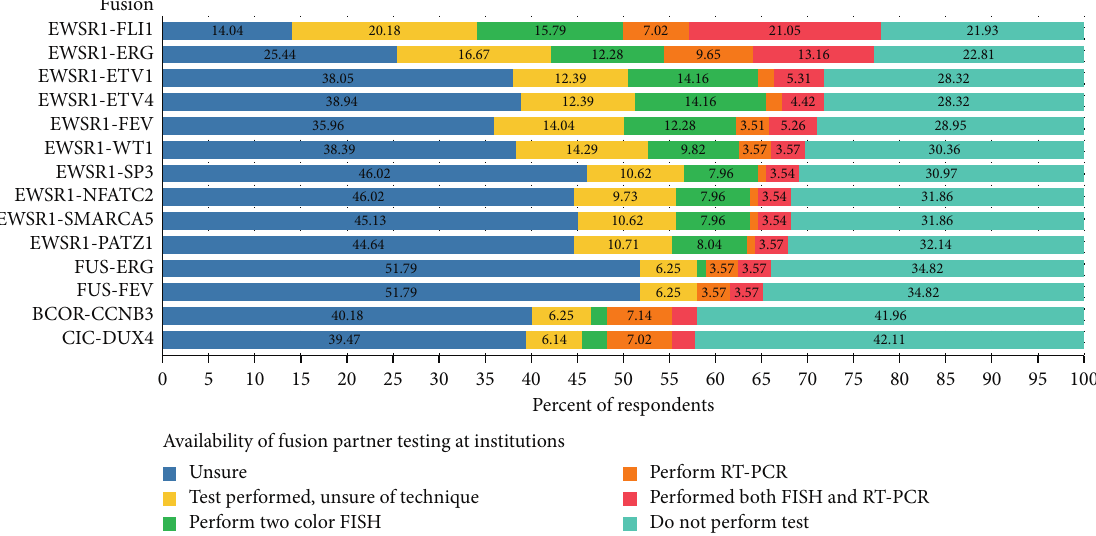
Figure 4: Available variant translocation fusion partner testing at respondent institutions. Data represent the respondent’s impression of the type of testing that is done at the local institution to determine fusion partner identity by two-color fish (green bar and percentage), RT-PCR (orange bar and percentage), or both (green bar and percentage). Other investigators were either unsure if testing is performed (blue bar and percentage), unsure of the type of testing (yellow bar and percentage), or do not perform testing (green bar and percentage).